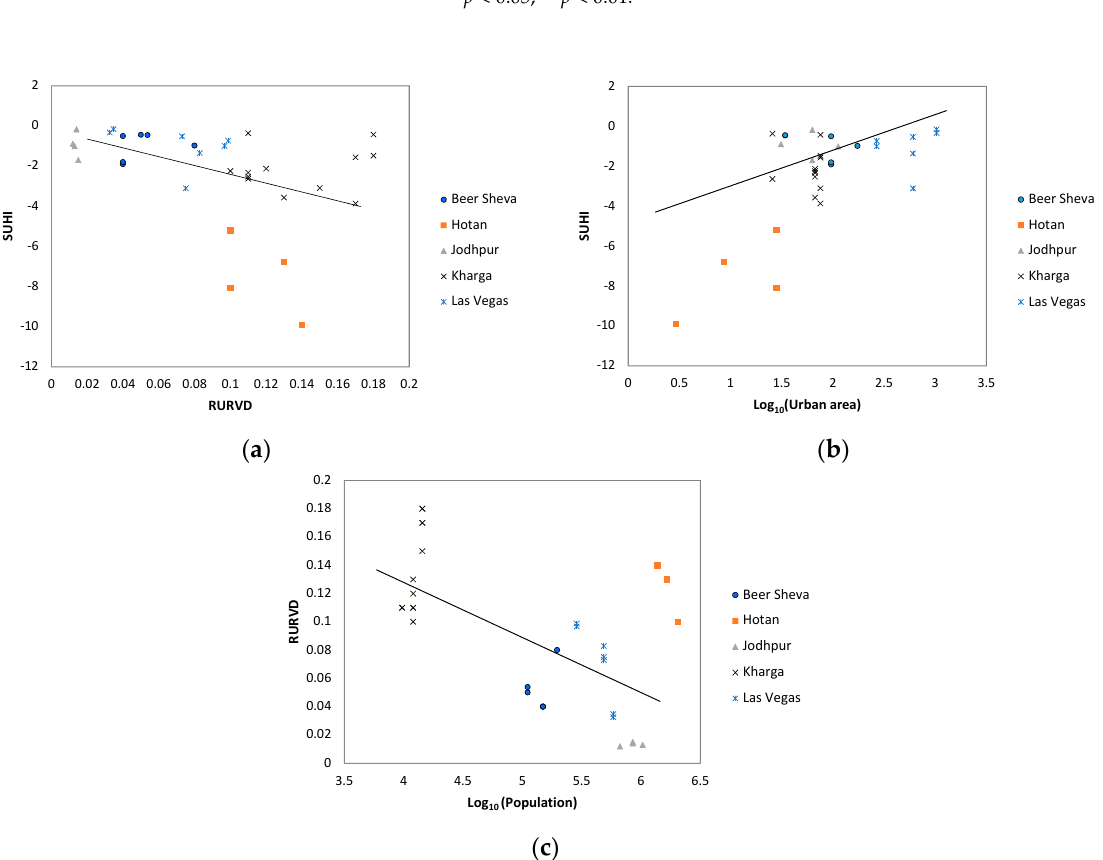
Figure 7. Relationship between ( a ) SUHI and RURVD; ( b ) SUHI and logarithm of urban area; ( c ) RURVD and logarithm of population.